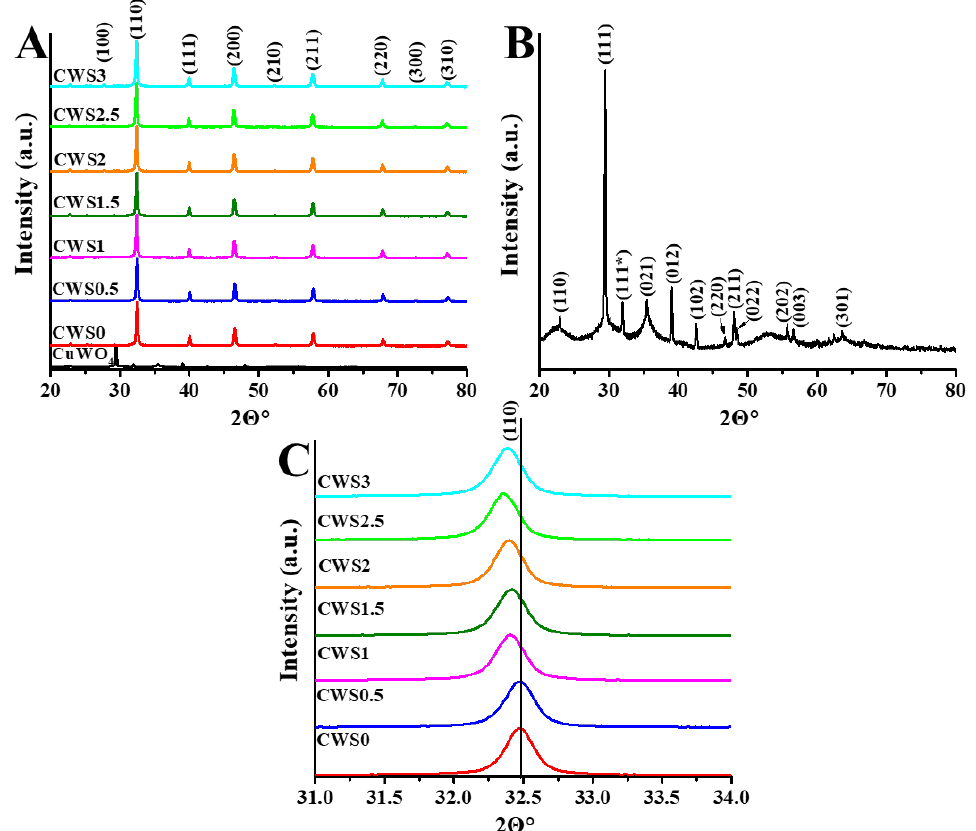
Figure 1. XRD patterns of SrTiO 3 (CWS0) and CuWO 4 -SrTiO 3 composite samples (CWSX) ( A ), CuWO 4 ( B ) and the main reflection shift ( C ).